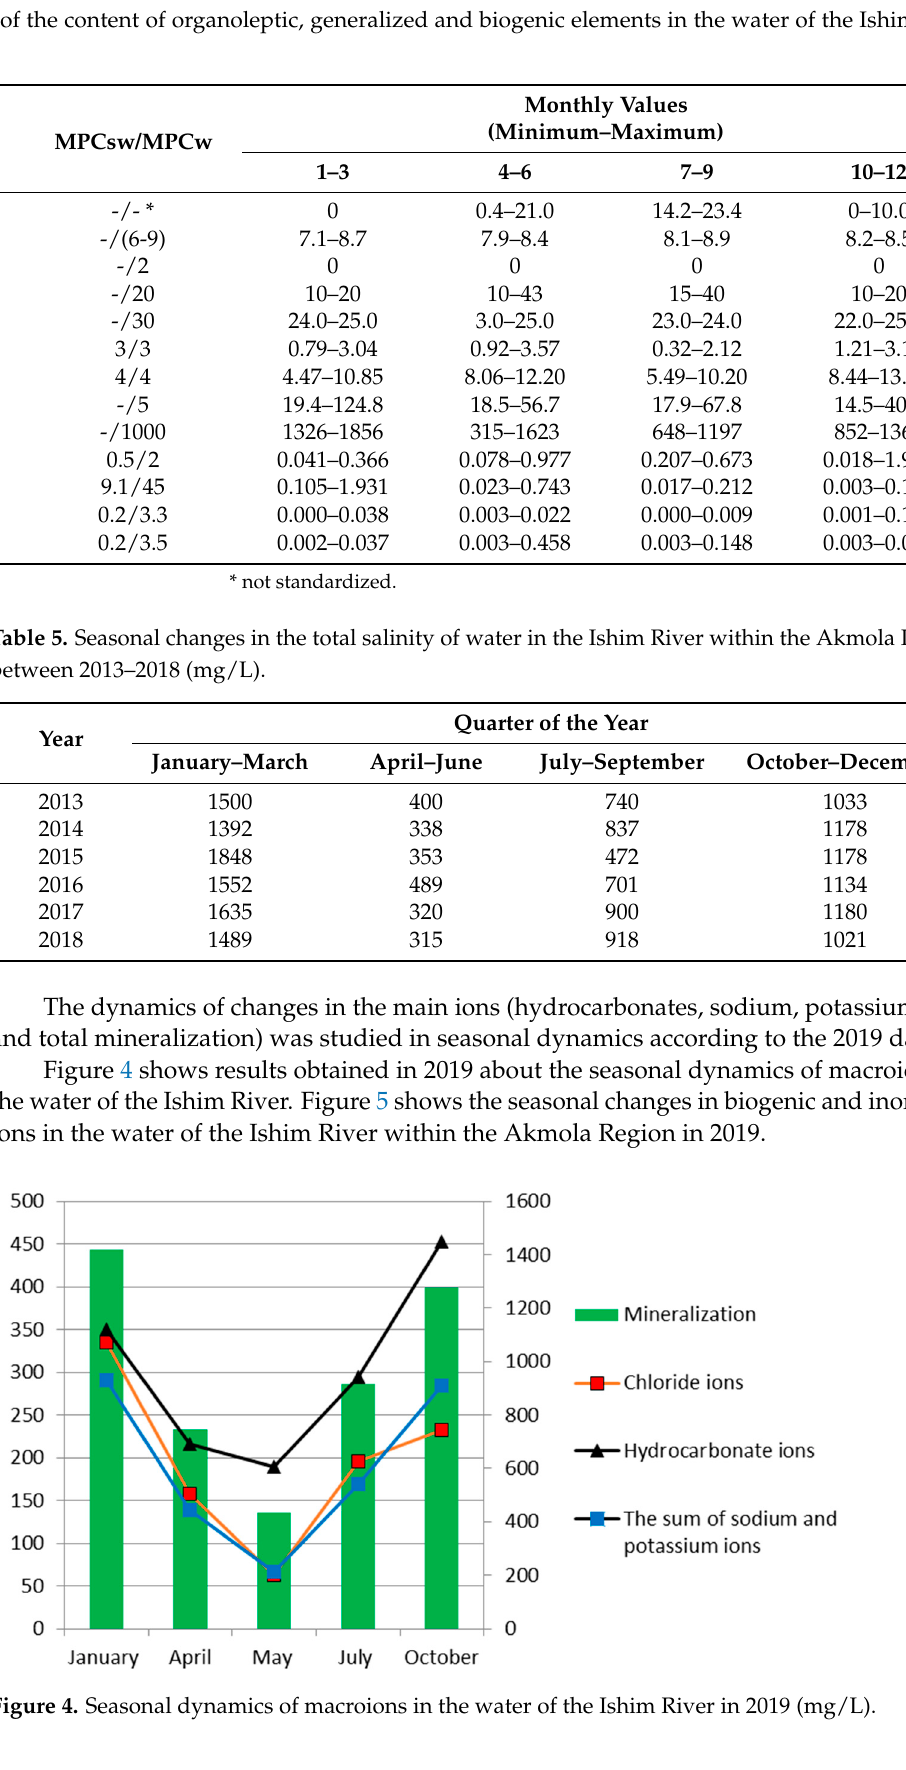
Figure 5. Seasonal changes in biogenic and inorganic ions in the water of the Ishim River within the Akmola Region in 2019 (mg/L) The content of microelements in water is an important indicator of its quality. Micro- elements are of great biological importance, but their excess can lead to undesirable phys- iological consequences in the human body and aquatic organisms and can worsen the general sanitary state of water bodies. Table 5 shows the content of microelements in the river waters, for which, in different years, the maximum permissible concentrations (MPCsw) for surface waters are exceeded. An important hydrochemical indicator of surface waters is mineralization, including the content of calcium and magnesium ions (determining the hardness of water) and the content of sulfates, chlorides and hydrocarbons, which determine the ionic composition of water. Moreover, the average content of heavy and rare earth metals—Pb, Cd, Co, Al and Ni have also been obtained. Results show that MPCsw values for Ni and Co are gen- erally exceeded at the Kamenny Quarry gauging station. The values of all these indicators are shown in Table 6. Table 7 shows the seasonal dynamics of the content of main ions, microelements and heavy metals.